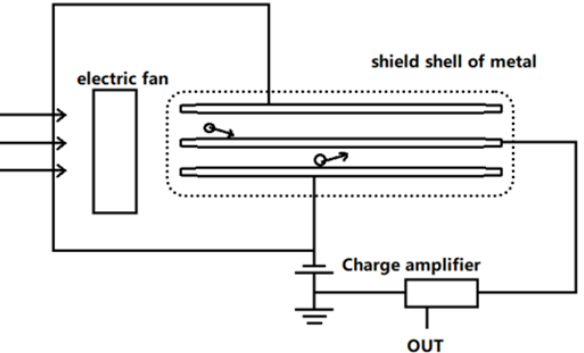
Figure 2. Structure of the cylindrical ion collection device (shield shell dimensions: 345 mm × 72 mm × 45 mm).